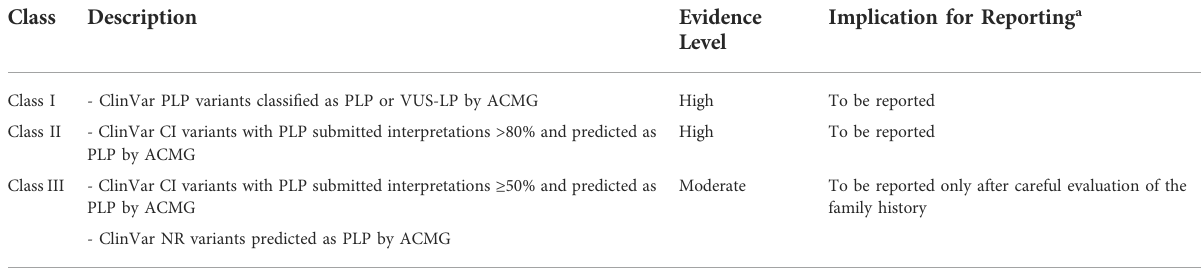
TABLE 1 Classi fi cation criteria of secondary fi